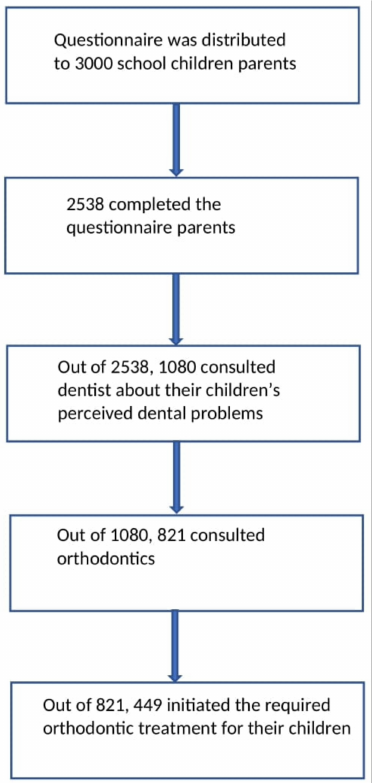
Figure 1. Flow diagram of the questionnaire distribution and